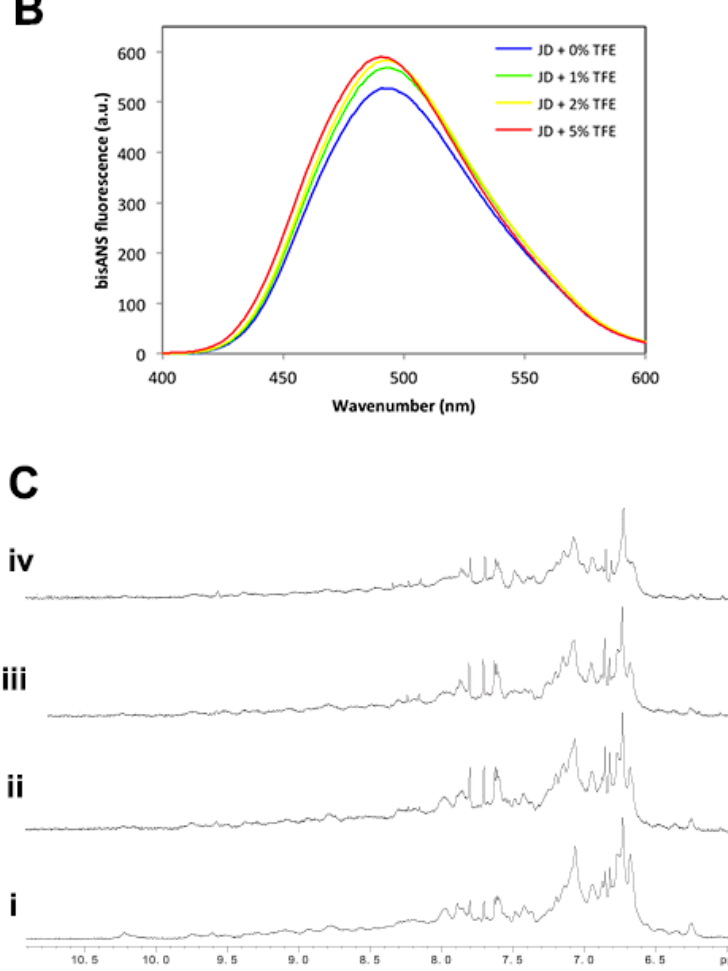
Figure 5. JD spectral properties immediately after TFE addition. ( A ) Tryptophan intrinsic fluorescence of freshly purified JD in the presence of 0%, 1%, 2% and 5% TFE ( v / v ); ( B ) BisANS binding assays of freshly prepared JD after the addition of 0%, 1%, 2% and 5% TFE ( v / v ); ( C ) 1 H-NMR titration. Spectra recorded in solution containing 0% (i), 1 (ii), 2 (iii) and 5 (iv) % TFE. All the measurements were performed at 25 °C.